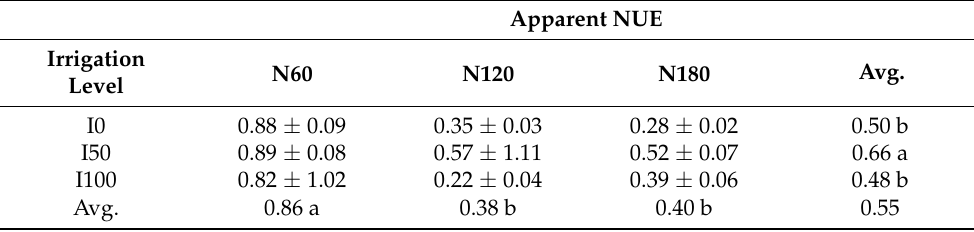
Table 2. Apparent N fertilizer use efficiency (ANUE) in relation to irrigation (I0, I50, I00 = 0, 50, 100% ETc, respectively) and N level (N0, N60, N120, N180 = 0, 60, 120, 180 kg ha − 1 , respectively), in sweet sorghum cv. Keller. Average values of all N levels (last column) and average values of all irrigation levels (last row) followed by the same letter do not significantly differ at p ≤ 0.05. The I × N interaction was not significant. Values of the standard error are